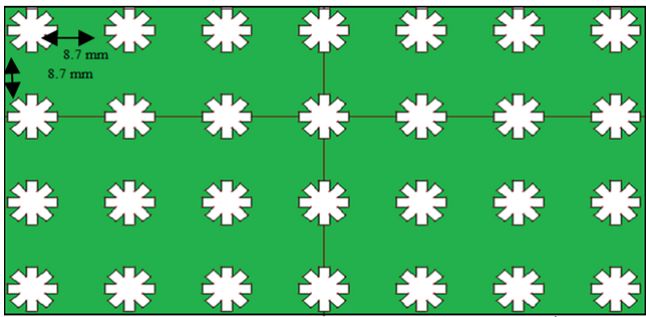
Figure 3. Schematic of unit cell of star Figure 4. Schematic of star slot EBG slot EBG structure.